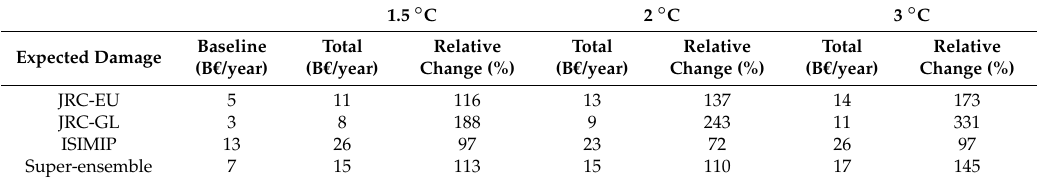
Table 2. Expected damage from the three case studies (ensemble average) at specific warming levels (SWLs), including relative change. Averages of the three ensembles are included in the last row.